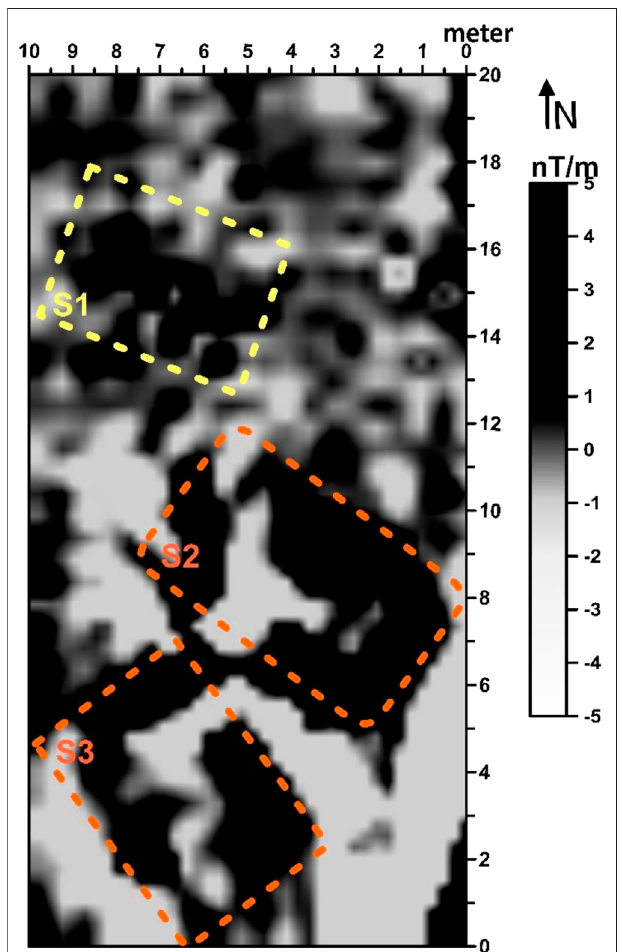
FIGURE 4 | Gradiometer data of site D, after applying the processing functions. This plot shows the interested magnetic anomaly zones. S1, S2, and S3 delineate the main discoveries in this